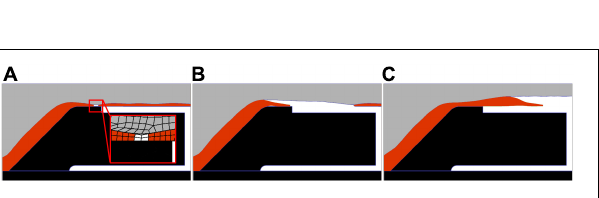
FIGURE 12 | Illustration of the processes during the occurrence of a sleeve fracture: (A) fracture of the copper sleeve, (B) bulging of the copper, (C) re-start of the composite extrusion; color legend: gray, aluminum; orange, copper; black, die and container; extrusion direction → .